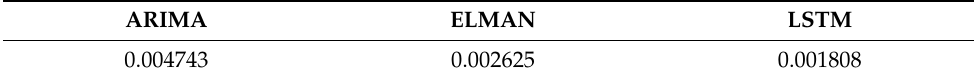
Table 2. Theil’s U coefficient.